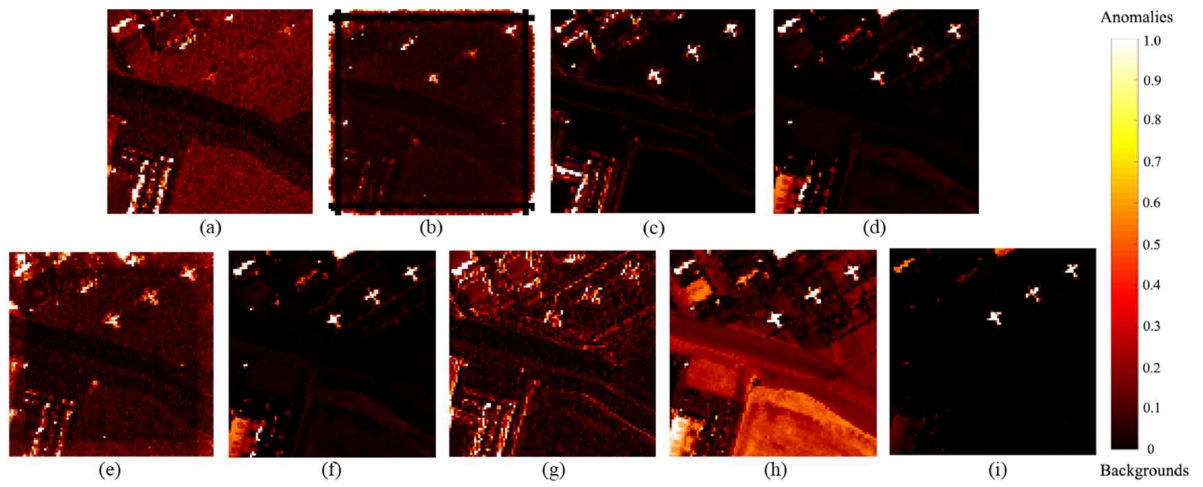
Figure 11. Detection results of the various algorithms for the San Diego Image: ( a ) RX, ( b ) LRX, ( c ) KRX, ( d ) SSRX, ( e ) CRD, ( f ) LSMAD, ( g ) GTVLRR, ( h ) PRLRaSAD, and ( i )